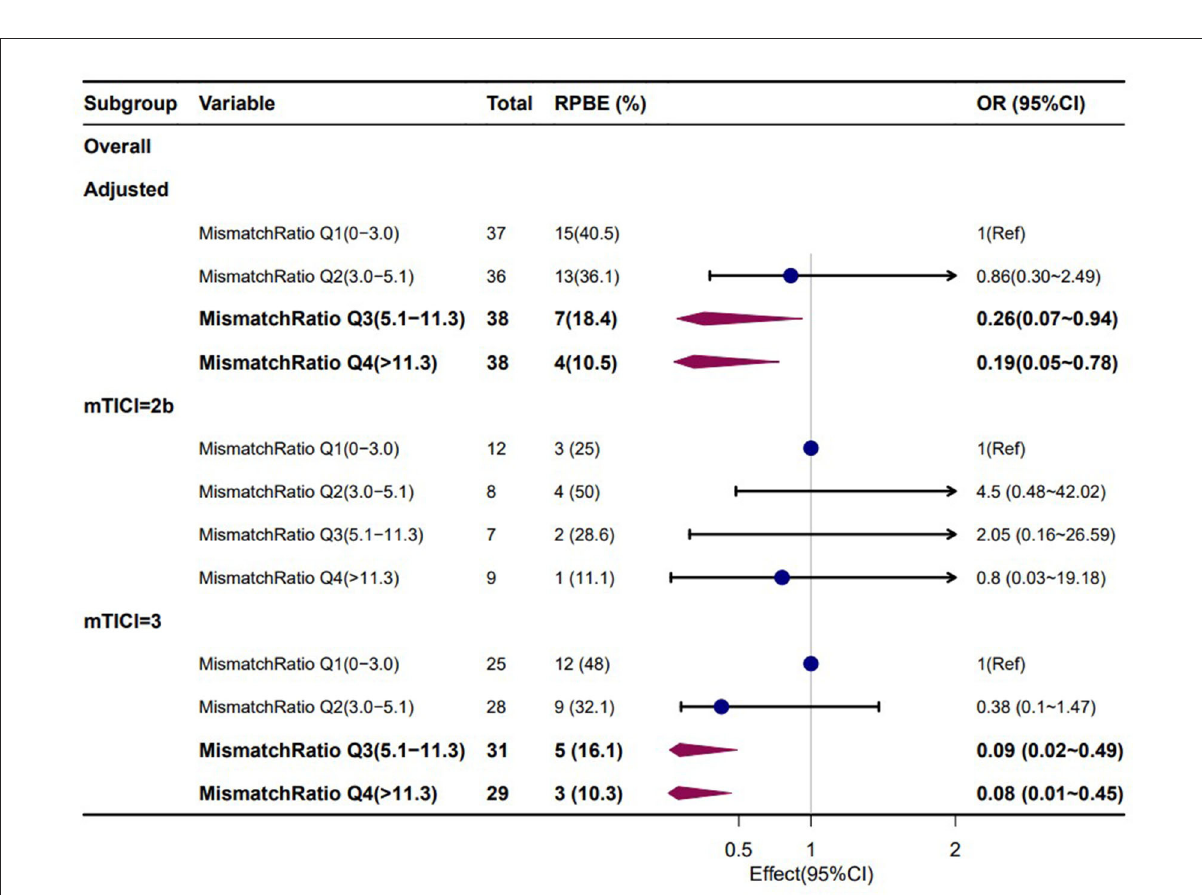
FIGURE3 Subgroup analyses for the associations of mismatch ratio with RPBE risk, adjusted for thrombolysis and CTP core